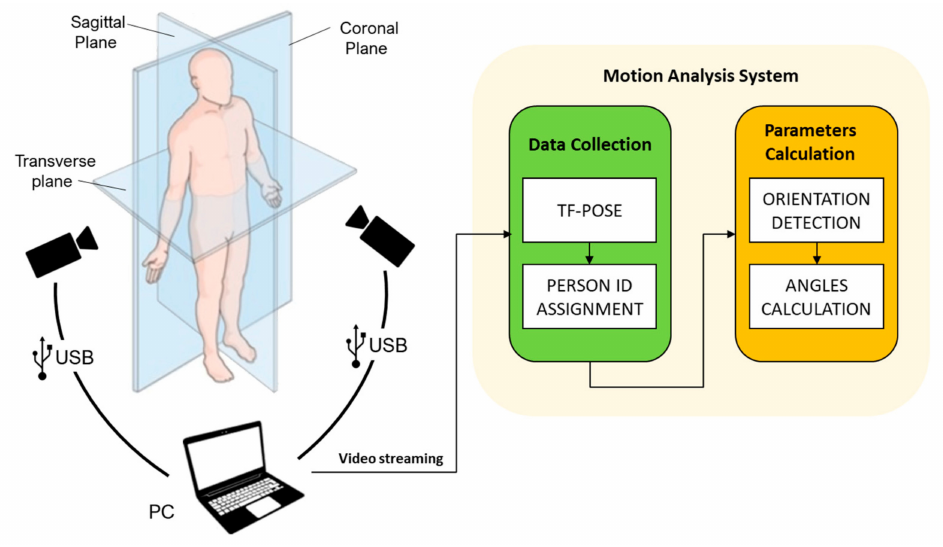
Figure 1. High-level software architecture and an example of possible hardware